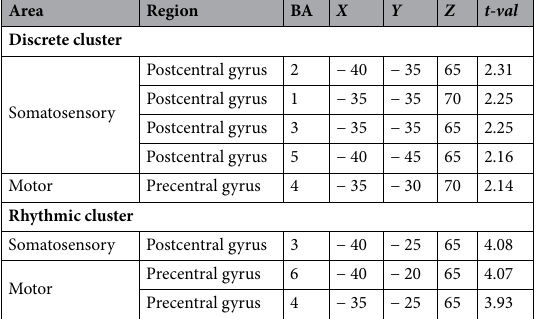
Table 2. Summary of significant activation from the brain sLORETA reconstruction . Significant ( P < .01, corrected) regions are indicated with the name of Brodmann area (BA), MNI coordinates (X, Y, Z) and t value ( t -val) of the higher statistical tresholded